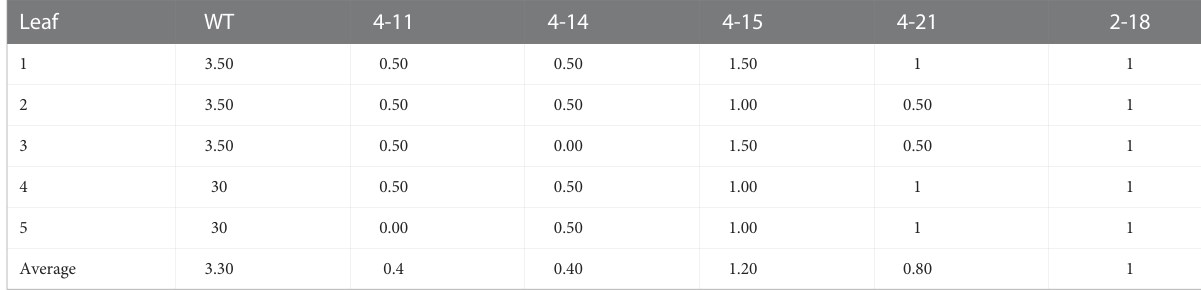
TABLE 1 DR scores at 10 dpi on different PM-inoculated leaves. Leaf